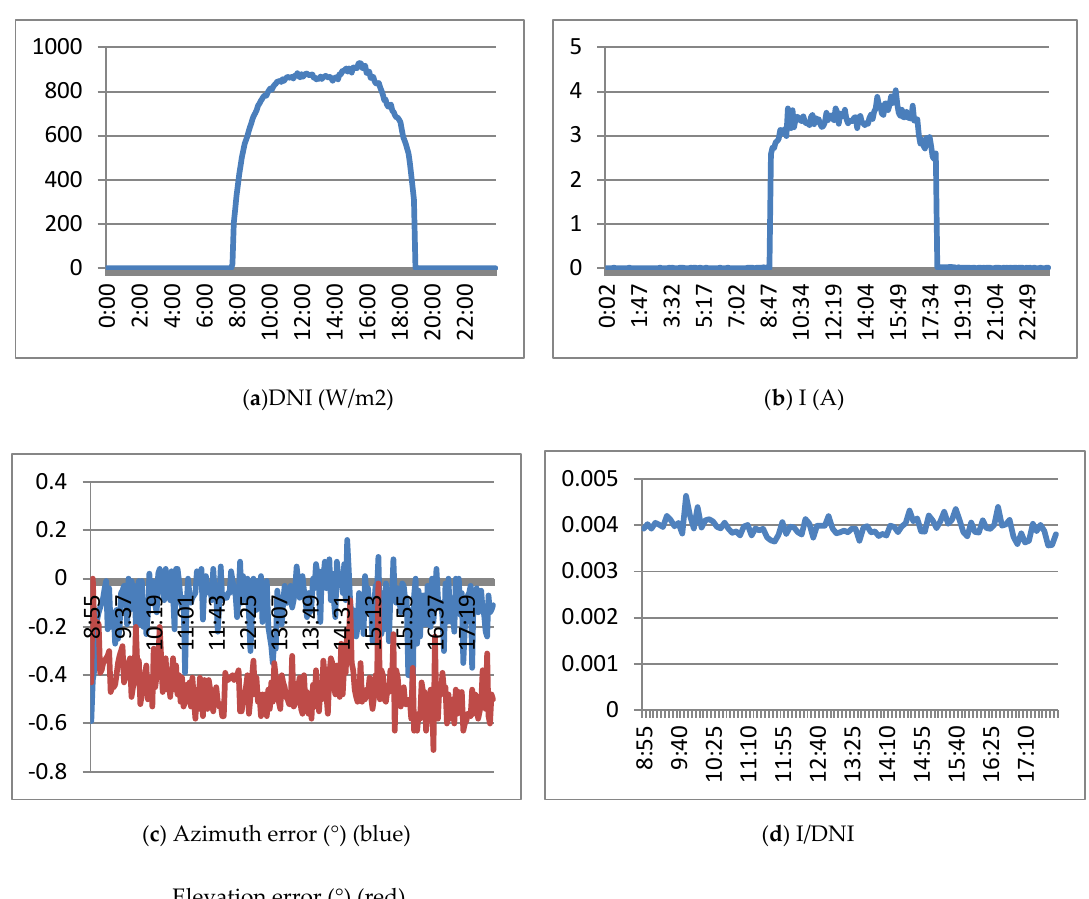
Figure 17. Results of the controller based on an FRBS sensor with the pointing device. March 12, 2019.